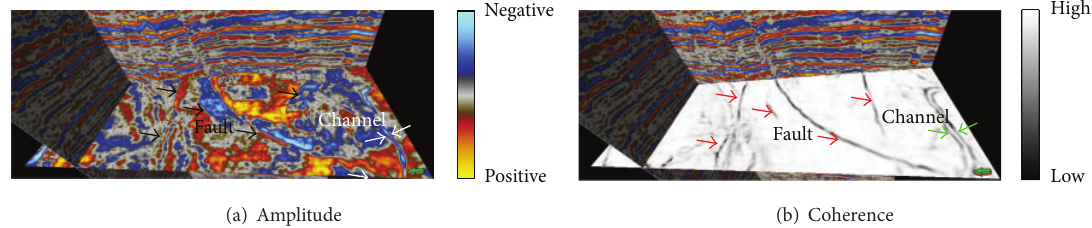
Figure 7: (a) Amplitude and (b) coherence attributes showing complex structure (faults and channel) in time slice 1950